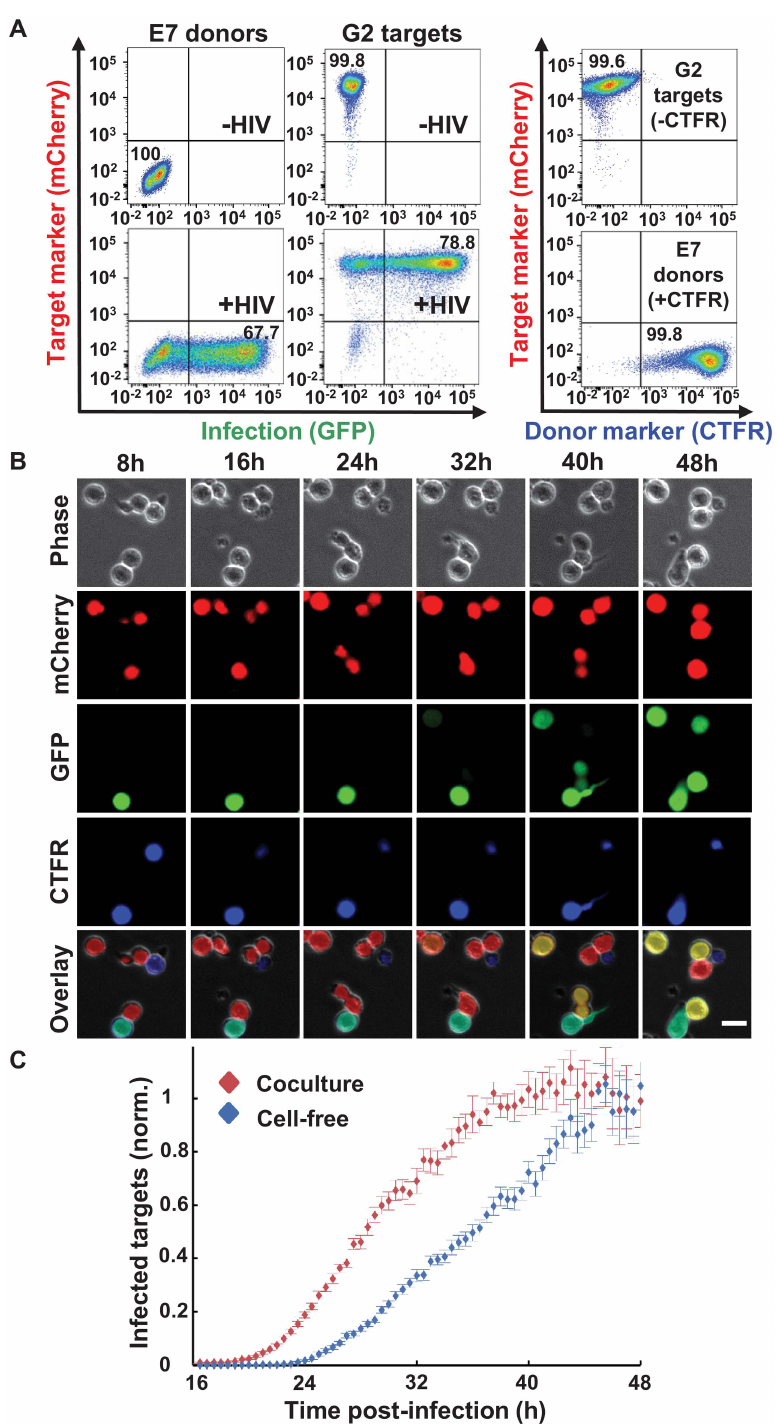
Fig 1. HIV cell-to-cell spread leads to earlier onset of HIV gene expression. ( A ) Infection system. Left column shows uninfected(top plot) or HIV infected (bottom plot) E7 donor cells. Middle column shows uninfected (top plot) or HIV infected (bottom plot) G2 target cells. Right column shows the labellingof donor cells with CTFR for donor-target fusion exclusion. Numbers are percent of cells in the associated quadrant. ( B ) Time-lapse images from one field of view (FOV). At each time point post-infection, cells were imagedfor GFP, mCherry, and CTFR fluorescence. Bar is 15 μ M. ( C ) Quantified timing of coculture (red) versus cell-free